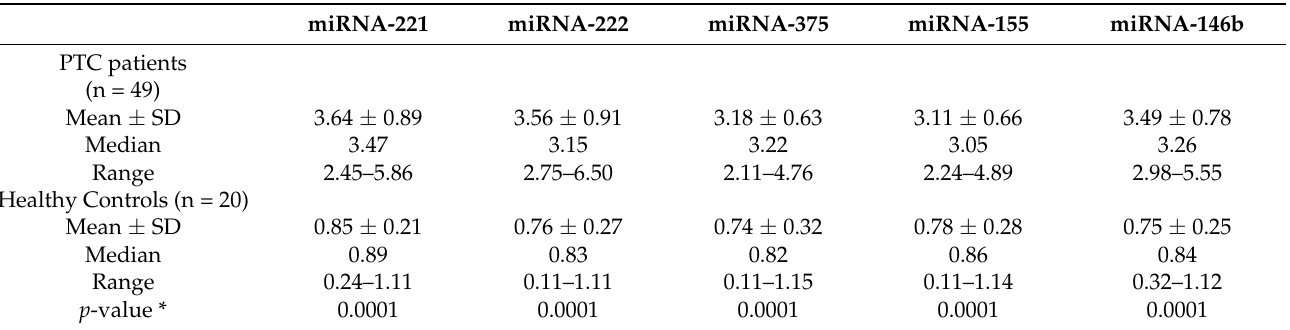
Table 1. Levels of the tested miRNAs in serum samples from the 49 PTC patients (at baseline) and 20 HCs (study entry sample). miRNA-221